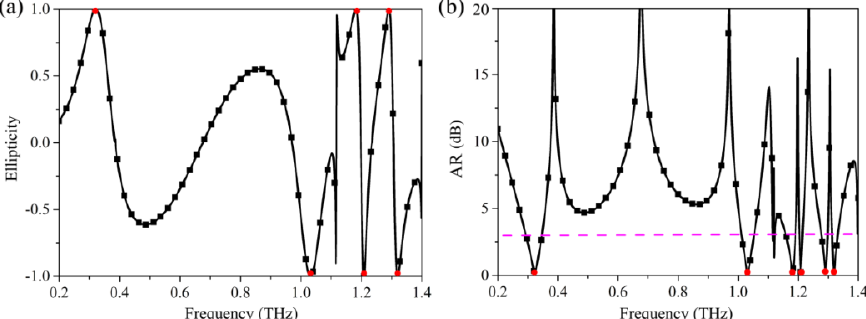
Figure 3. ( a ) The ellipticity and ( b ) AR of the designed metasurface for incident x-polarized wave. The purple dashed line denotes the AR of 3 dB.